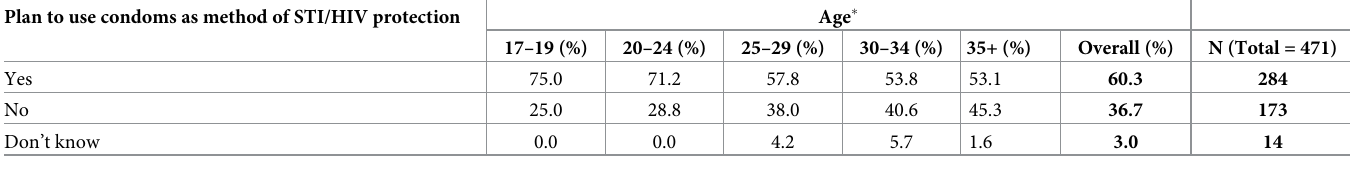
Table 3. Intention to use condoms percentage of women ages 17–49 who report they plan to use condoms for protection against STIs, including HIV, by age group, Tanzania 2018.